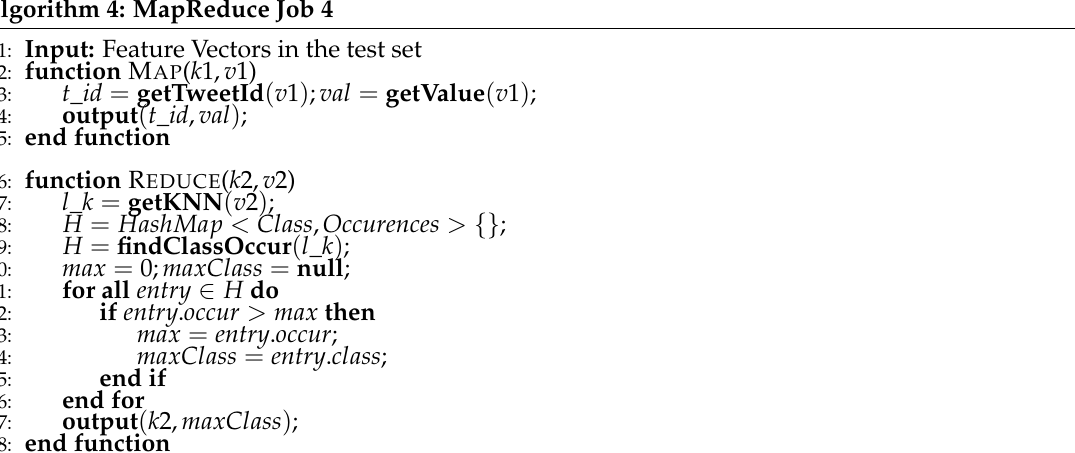
Algorithm 4: MapReduce Job